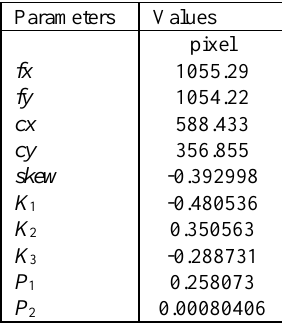
Table 4. Action camera calibration parameters on 3D test